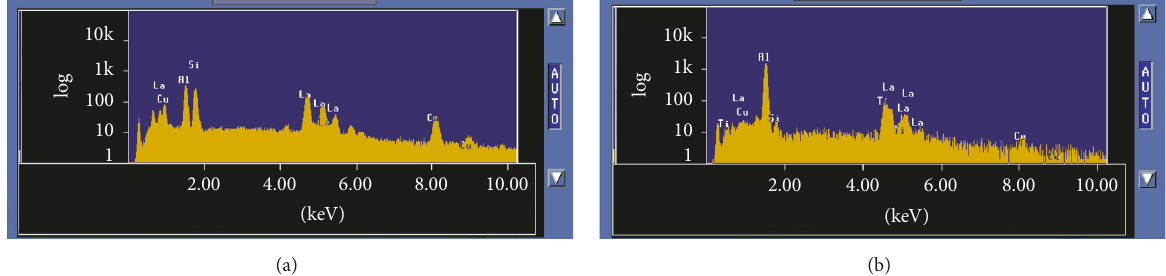
Figure 11: EDS spectra obtained from (a) the white phase and (b) the grey phase observed in the 1wt% La-containing alloy shown in Figure 8 corresponding to (a) 0.05 wt% Ti and (b) 0.15 wt%